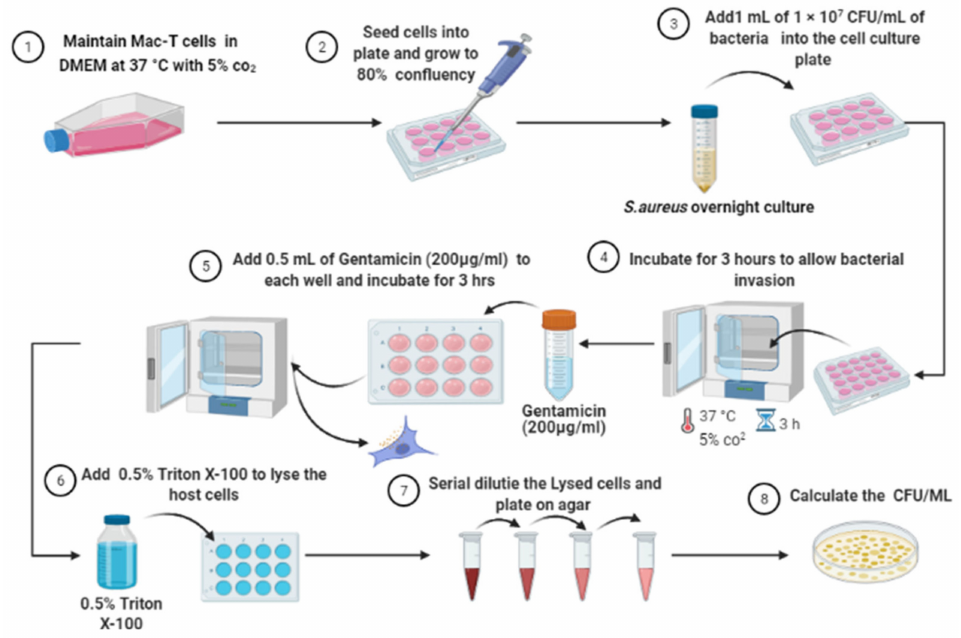
Figure 2. Flowchart of intracellular infection of bovine mammary epithelial cells (Mac-T cells) by S. aureus using a gentamicin protection assay [22]. The image was created using BioRender.com.2021 (Toronto, ON,